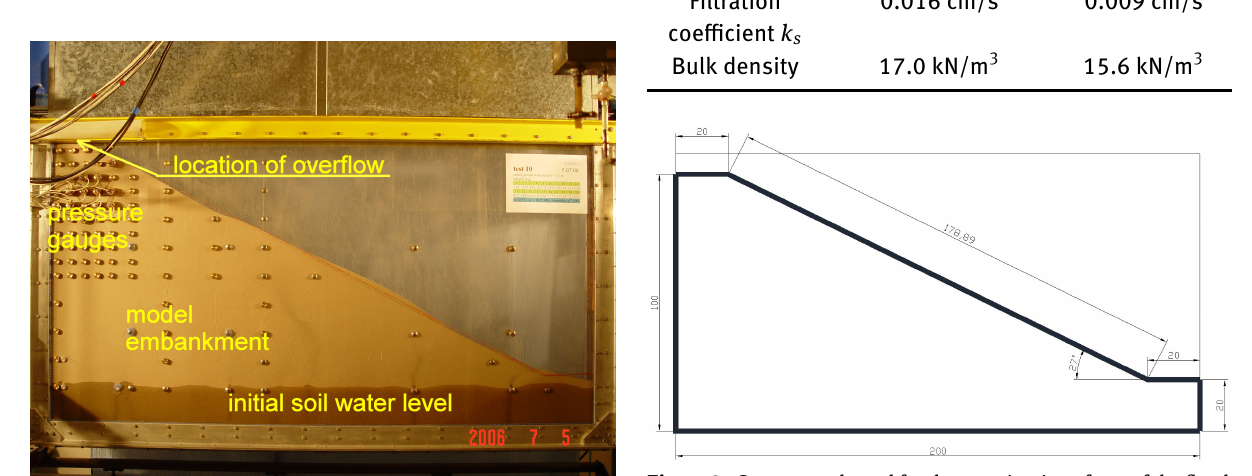
Figure 2a Geometry adopted for the examination of one of the flood embankment model’s slopes.